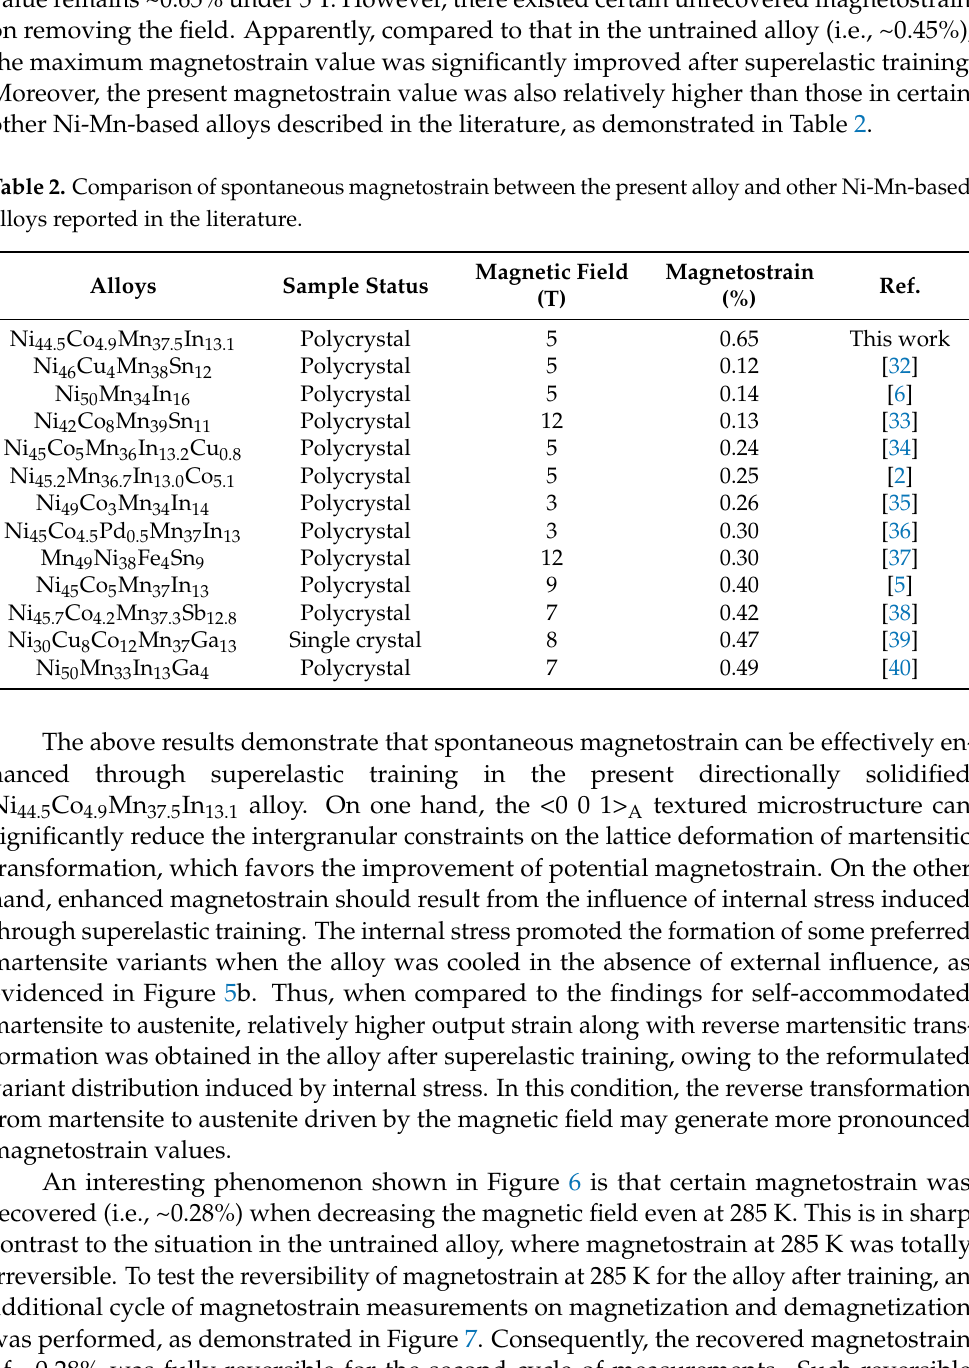
Magnetic Field Magnetostrain (T) (%)